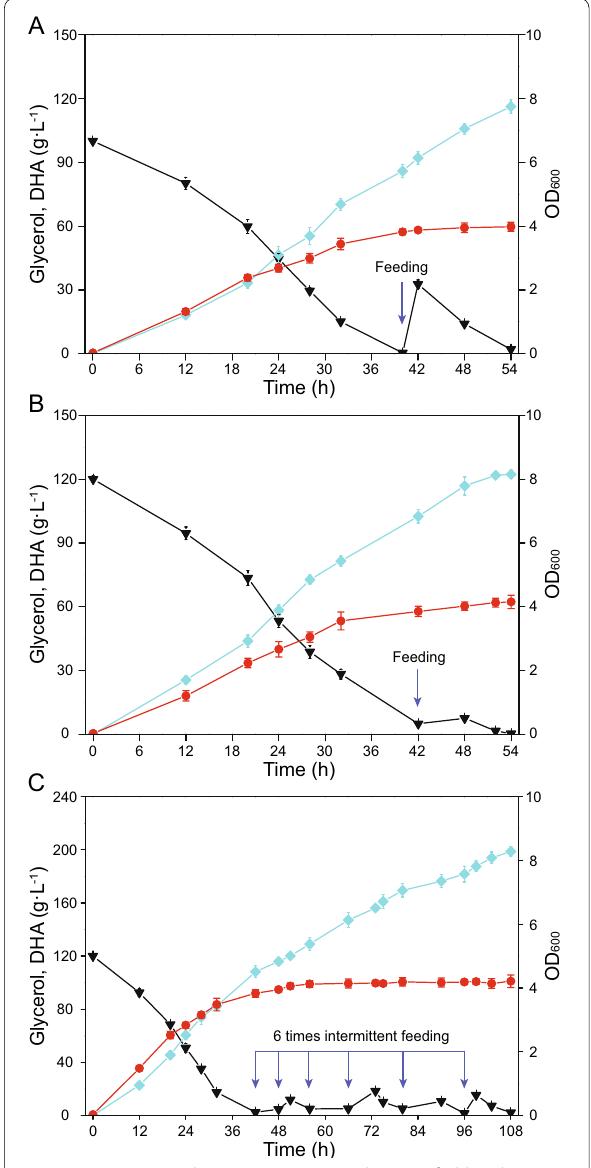
Fig. 4 Time courses showing DHA accumulation using Fig. 5 Time courses showing DHA accumulation in fed-batch different initial glycerol concentrations. Fermentation of fermentations. Fermentation of engineered strain G. oxydans engineered strain G. oxydans WSH-003–4 was conducted in WSH-003–4 was conducted in 5 L bioreactor. A Initial glycerol 5 L bioreactor. A Initial glycerol concentration 100 g L − 1 . addition was 100 g L − 1 , and then 40 g L − 1 glycerol was fed at 40 h = B Initial glycerol concentration 120 g L − 1 . C Initial glycerol (Total glycerol addition was 140 g L − 1 ). B Initial glycerol addition was = concentration 140 g L − 1 . Black triangles; glycerol, blue squares; 120 g L − 1 , and then 20 g L − 1 glycerol was fed at 42 h (Total glycerol = DHA, red circles; OD 600 addition was 140 g L − 1 ). C Initial glycerol addition was 120 g L − 1 , and then glycerol was intermittently fed (20 g L − 1 each time) at 42 h, 48 h, 56 h, 66 h, 80 h, and 96 h (Total glycerol addition was 240 g L − 1 ). Black triangles; glycerol, blue squares; DHA, red circles;